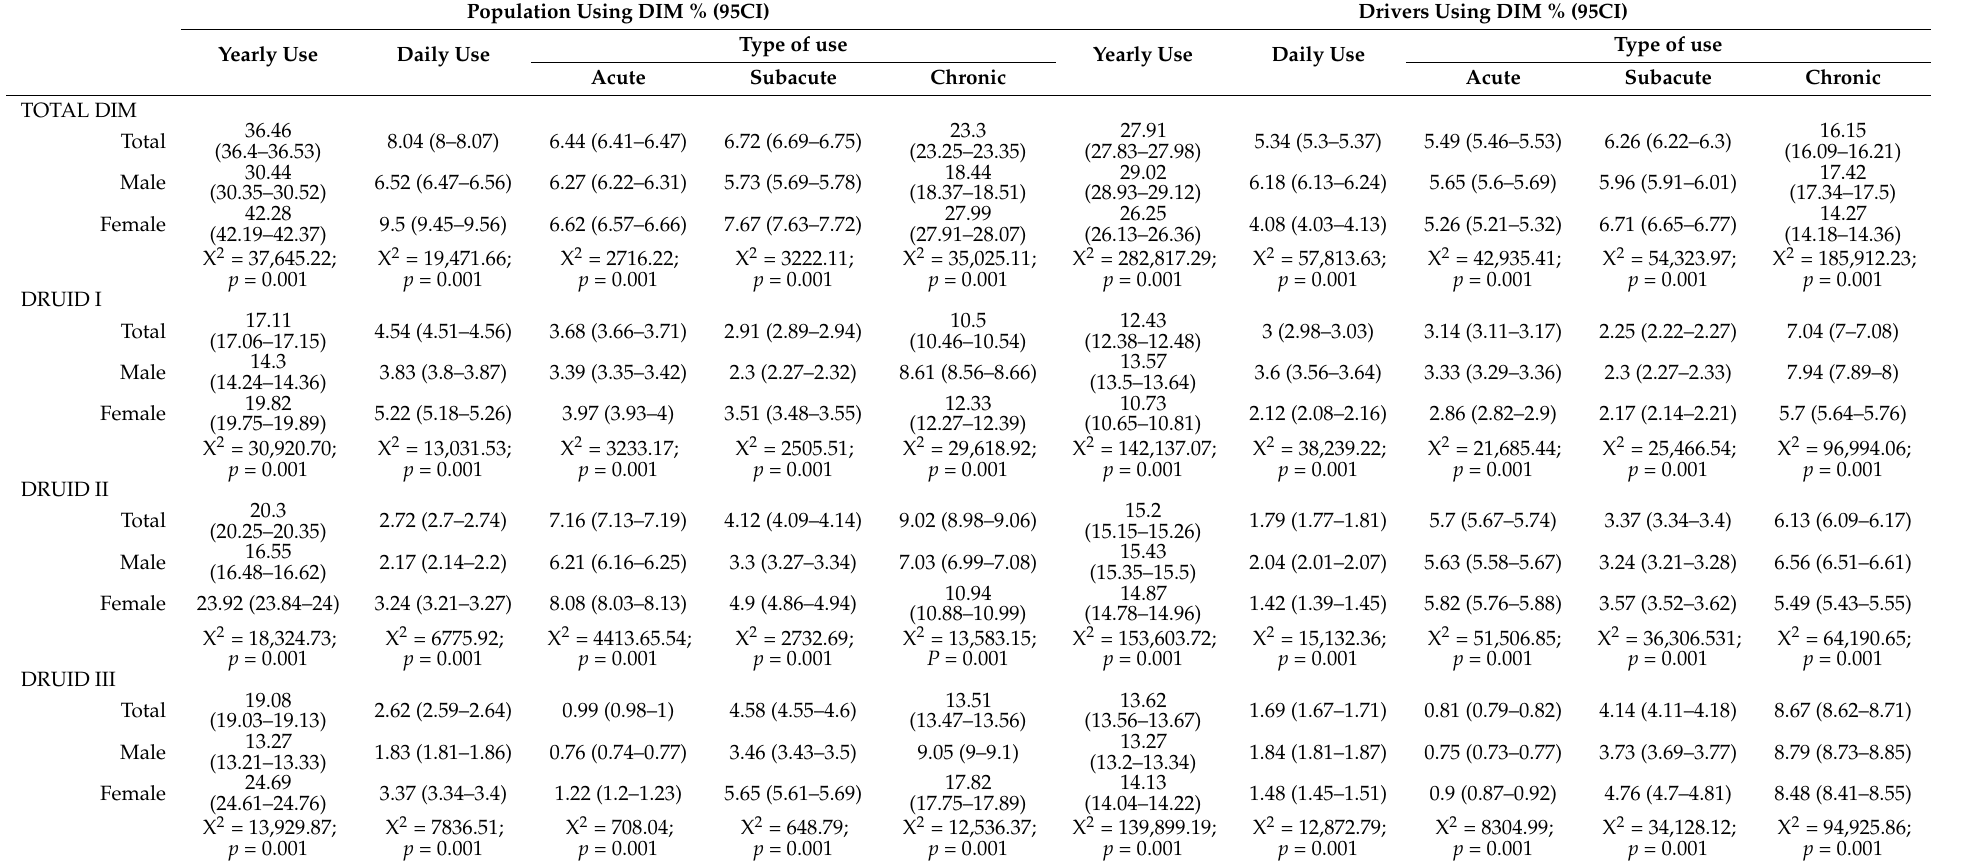
Table 1. Use of DIMs according to the CONCYLIA database and the Castile and Le ó n drivers’ license census